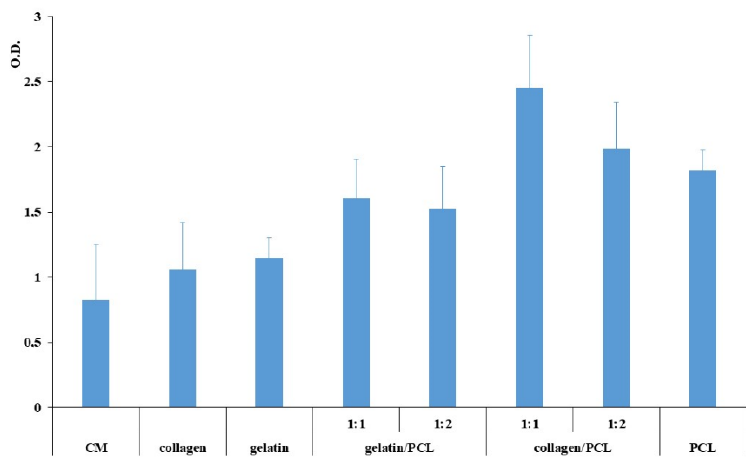
Figure 13. Cell viability (Optical density O.D.) after 7 days of normal human dermal fibroblasts (NHDF) seeded on nanofibrous membranes based on collagen, gelatin, gelatin/PCL, collagen/PCL and PCL (ANOVA 1 via—MRT ( p < 0.05) mean values ± s.d., n = 8). Statistically significant differences: Gelatin/PCL 1:1 (w/w) and 1:2 (w/w) vs control (CM), collagen/PCL 1:1 (w/w) and 1:2 (w/w) vs control, PCL vs control, collagen/PCL 1:1 (w/w) vs gelatin/PCL 1:1 (w/w), collagen/PCL 1:1 (w/w) vs PCL, Collagen/PCL 1:1 (w/w) and 1:2 (w/w) vs collagen, gelatin/PCL 1:1 (w/w) and 1:2 (w/w) vs gelatin.